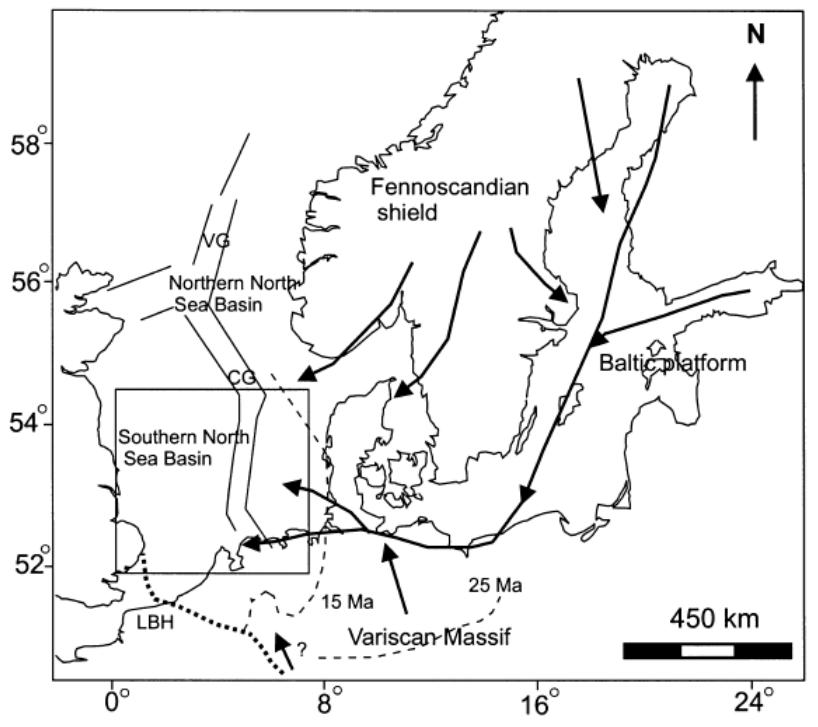
Figure 2. The Eridanos fluvio-deltaic system of the North-West European Basin [36–39].